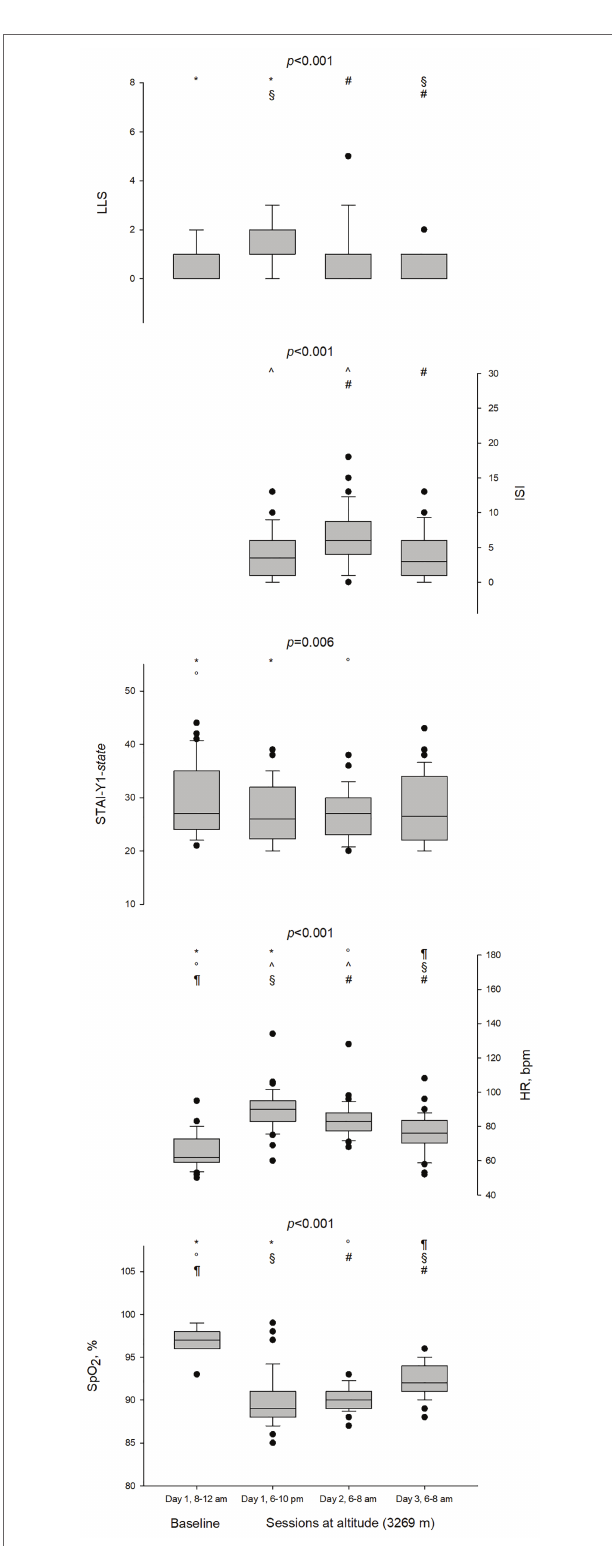
FIGURE 2 | Boxplots of Lake Louise Score (LLS), Insomnia Severity Index (ISI), State and Trait Anxiety Inventory (STAI-Y1- state ), Heart rate (HR),